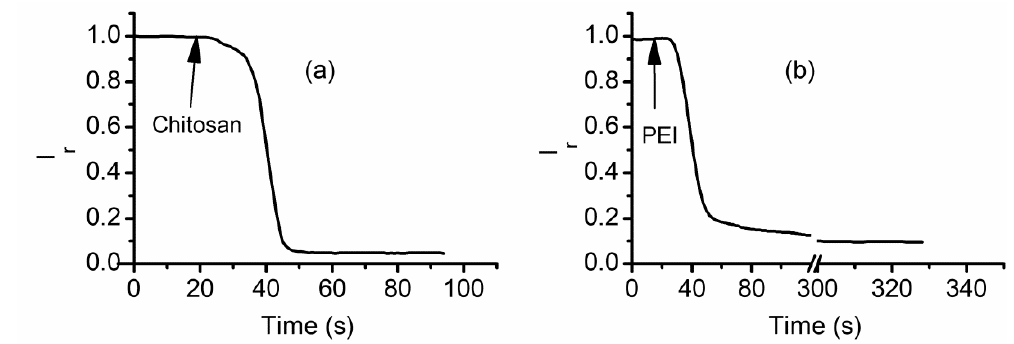
Figure 9. Cationic polymers inhibit the ionic currents through lysenin channels. The evolution of the relative ionic currents measured through lysenin channels upon exposure to ( a ) 8 µM chitosan, and ( b ) 4 µM PEI. Published under Creative Common Attribution License in [63].